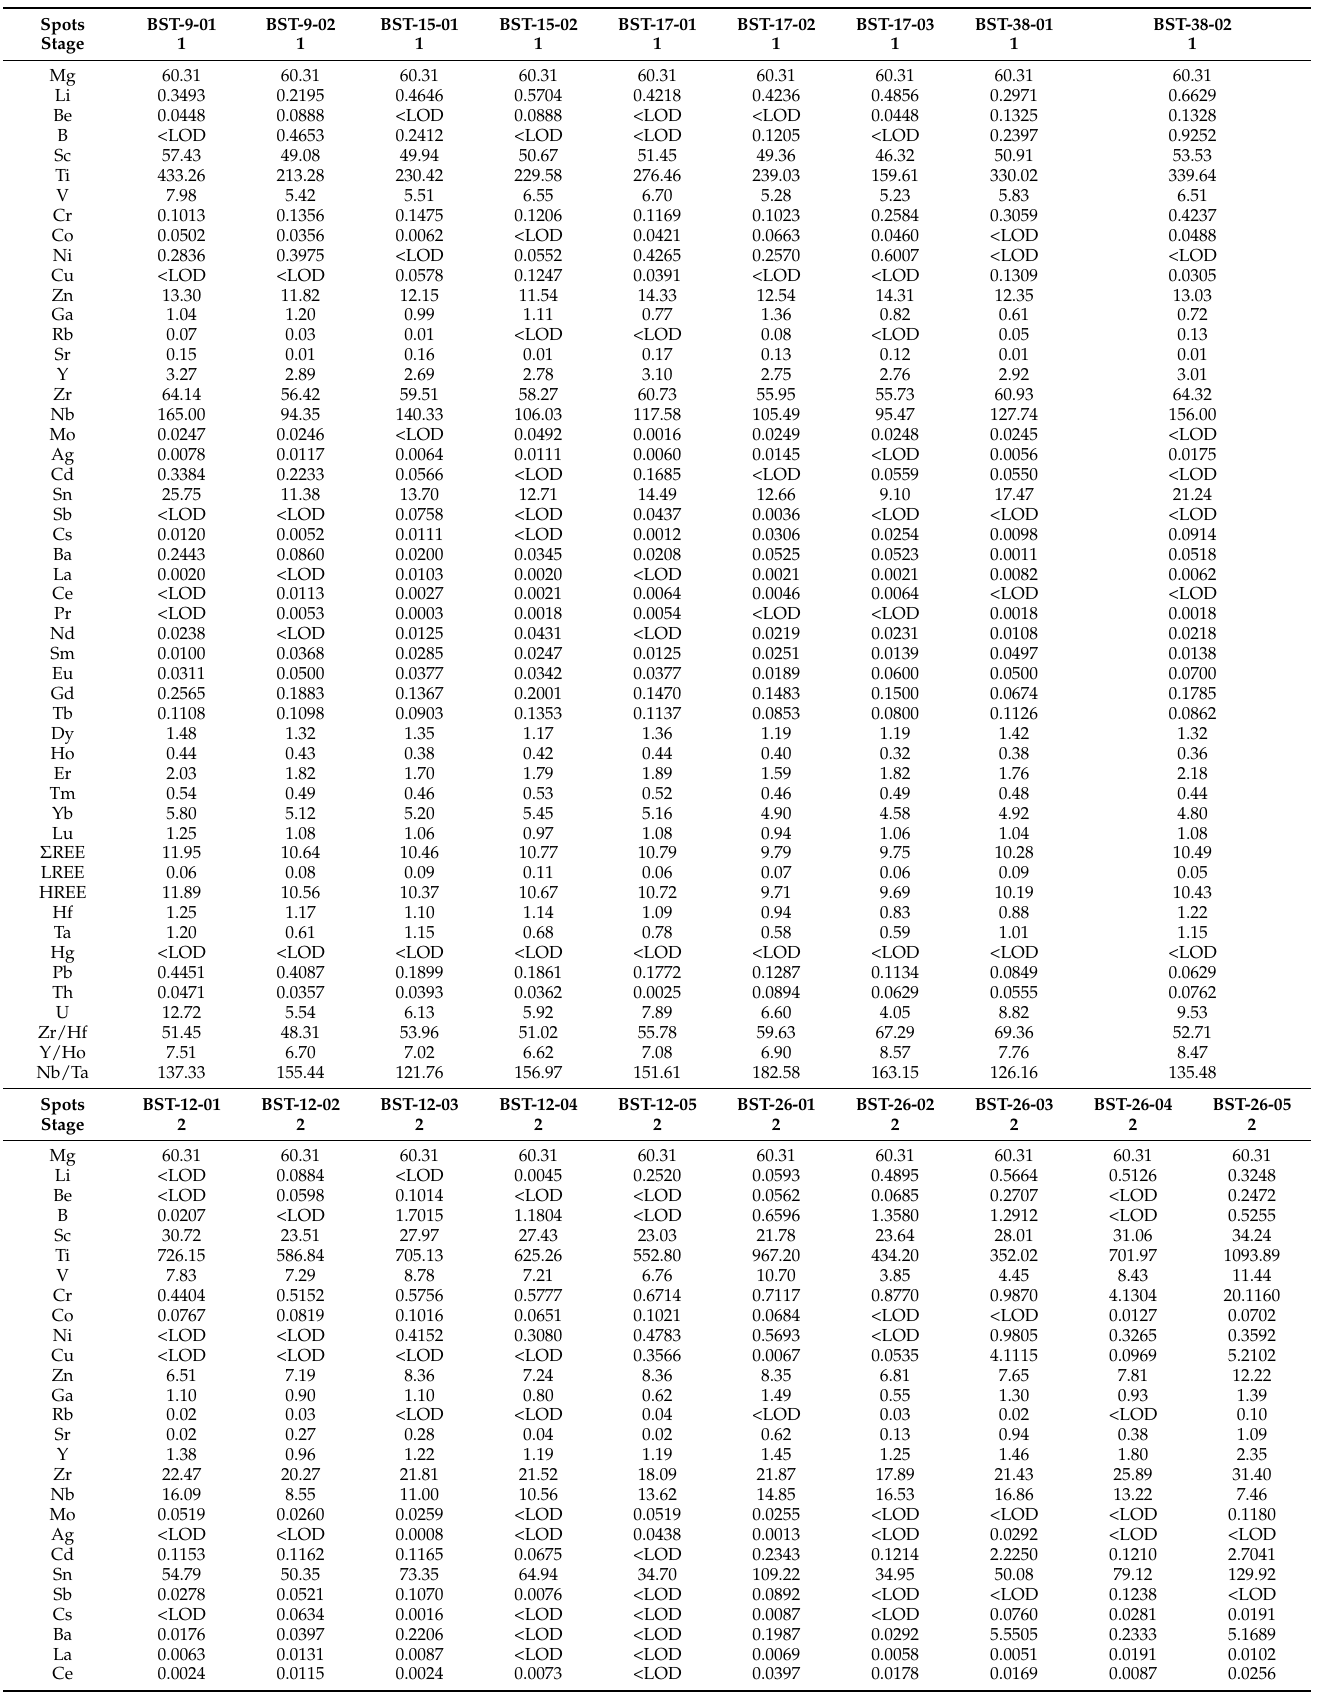
Table 3. Chemical composition of wolframite by LA-ICP-MS (in